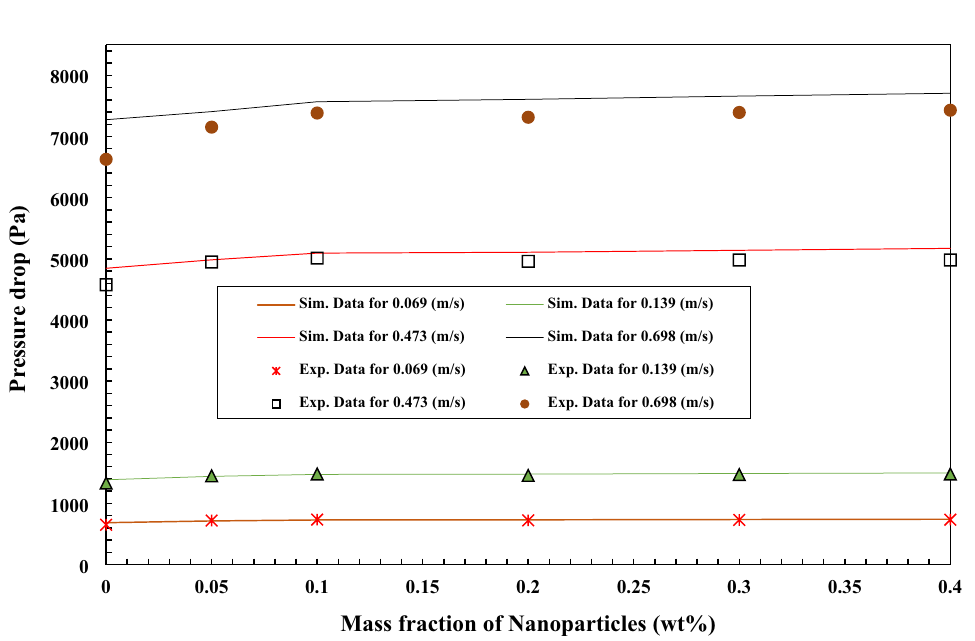
Figure 23. Comparison of experimental and simulation data of the pressure drop of the nanofluids in different mass fraction of TiO 2 nano